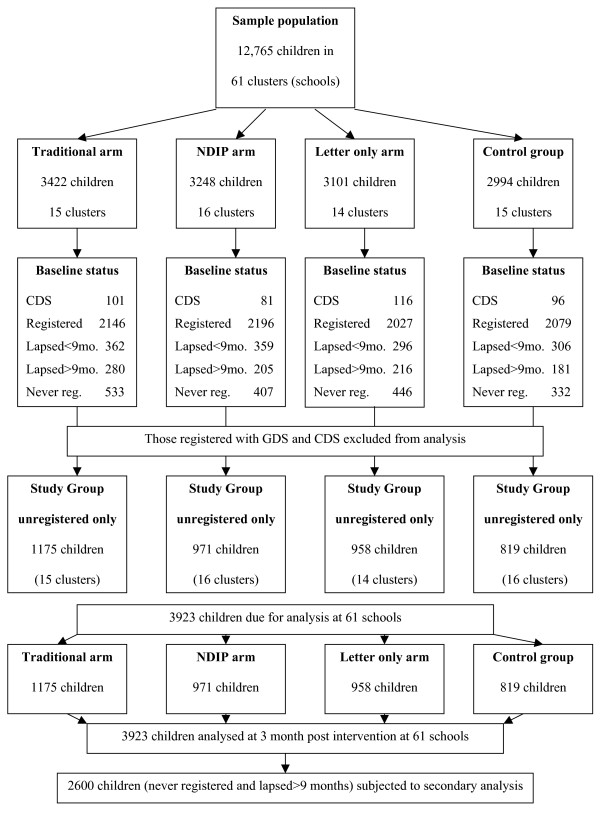
Illustration of the composition within each arm of the study.